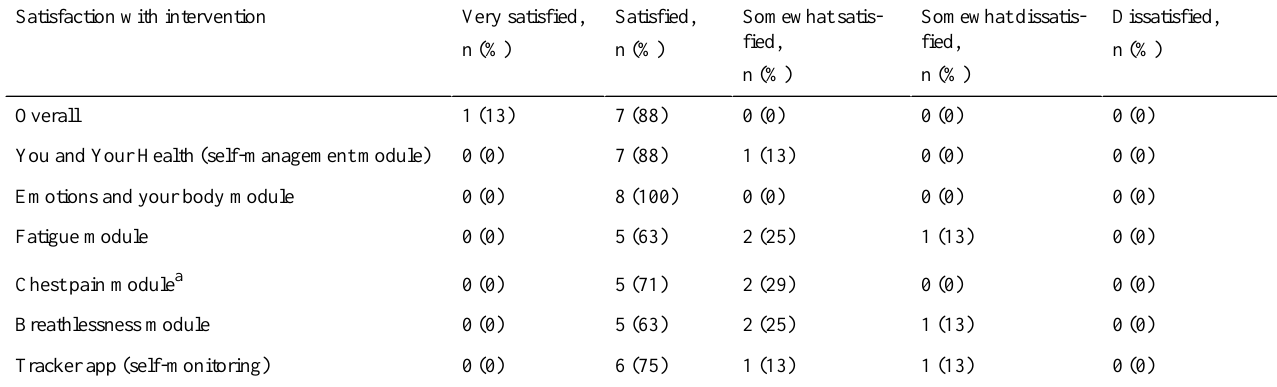
Table 6. Participant responses to satisfaction items